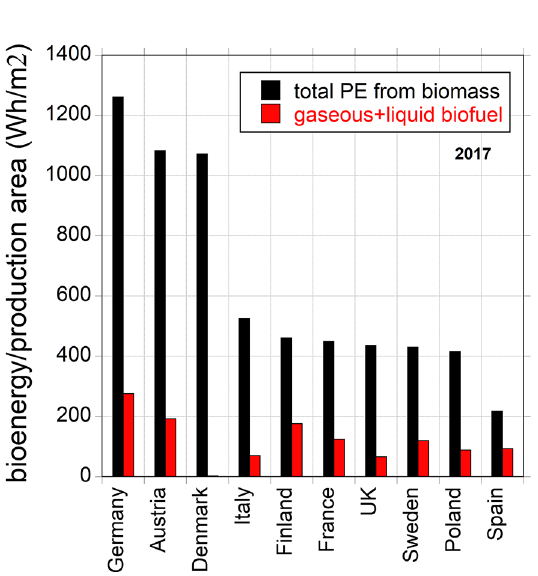
Fig. 8. – The ratio of total primary energy ( PE ) or gaseous and liquid biofuels, respectively, to the related production area is shown for various European countries for 2017. Data are from IEA and Index